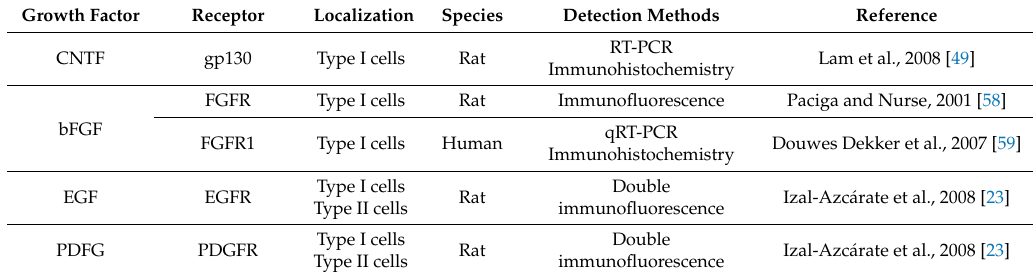
Table 7. Ciliary neurotrophic factor family, fibroblast growth factor, epidermal growth factor family, and platelet-derived growth factor receptors. Expression of gp130, FGFR, EGFR, and PDGFR in the carotid